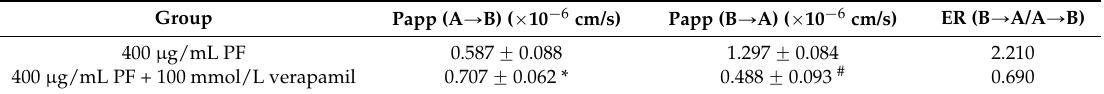
Table 2. The effect of P-gp inhibitors on transport of PF in MDCK-MDR1 cell monolayer.